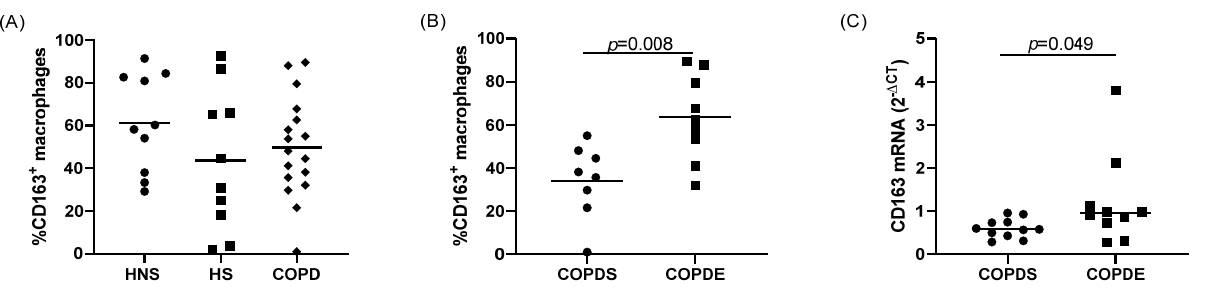
Figure 2. Macrophage CD163 protein and gene expression. The percentage of CD163+ macrophages were quantified in sputum from n = 10 healthy non-smokers (HNS), n = 10 healthy smokers (HS) and n = 17 COPD patients by flow cytometry ( A ). The percentage of CD163+ macrophages were compared between n = 8 COPD current smokers (COPDS) and n = 9 COPD ex-smokers (COPDE) ( B ). CD163 gene expression was quantified by real time PCR in macrophages isolated from the lung tissue of n = 11 COPDS and n = 10 COPDE ( C ). Data are presented as individual values with mean ( A , B ) or median ( C ).